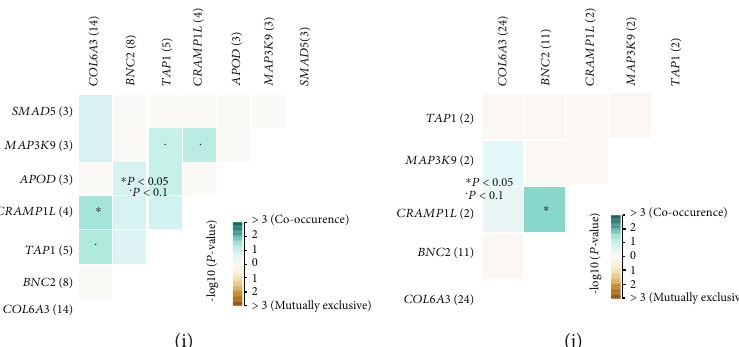
Figure 9: Mutation correlation analysis. (a, b) Mutation landscape of the top 30 genes in the high-risk group and mutation landscape of the 8 genes in the model. (c, d) The map of mutation landscape in the low-risk group and gene mutation in the model. (e, f) The relationship between gene TTN and overall survival in high- and low-risk groups. (g, h) The relationship between gene FAT3 and overall survival in the high- and low-risk groups. (i, j) The mutation symbiosis diagram of genes in the model in the high- and low-risk